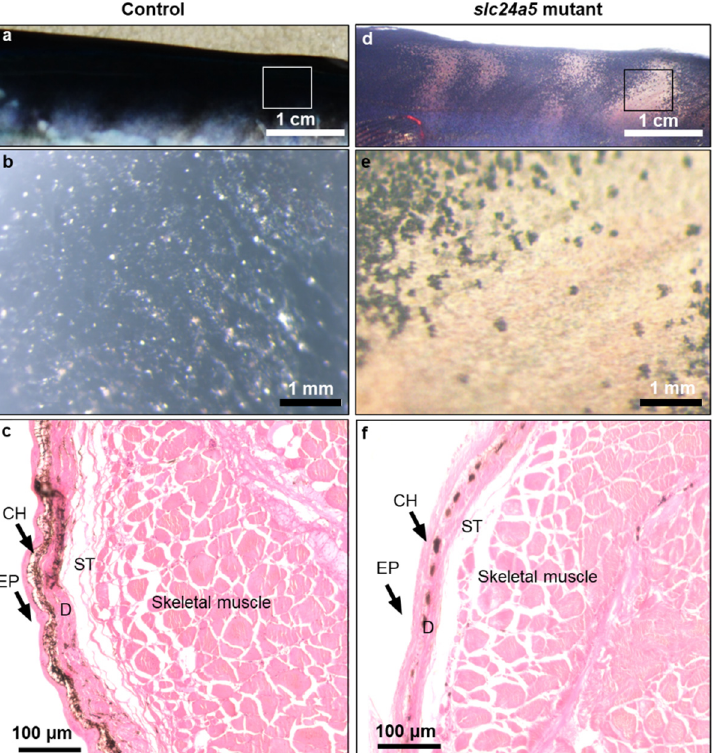
Figure 7. Melanin pigmentation of dorsal skin of kawakawa at 60 dpf. Pigmentation phenotype of the dorsal skin of a control juvenile ( a ) and slc24a5 mutant ( d ). Squared regions in ( a , d ) are enlarged in ( b , e ), respectively. Images of ( c , f ) were derived from a histological section after HE-staining of the dorsal skin from the control and slc24a5 mutant, respectively. Lower level of pigmentation on the dorsal skin of the slc24a5 mutant was further confirmed in the histological section, showing fewer melanophores under the epidermis. CH: chromatophore; EP: epidermis; D: dermis; ST: stratum.